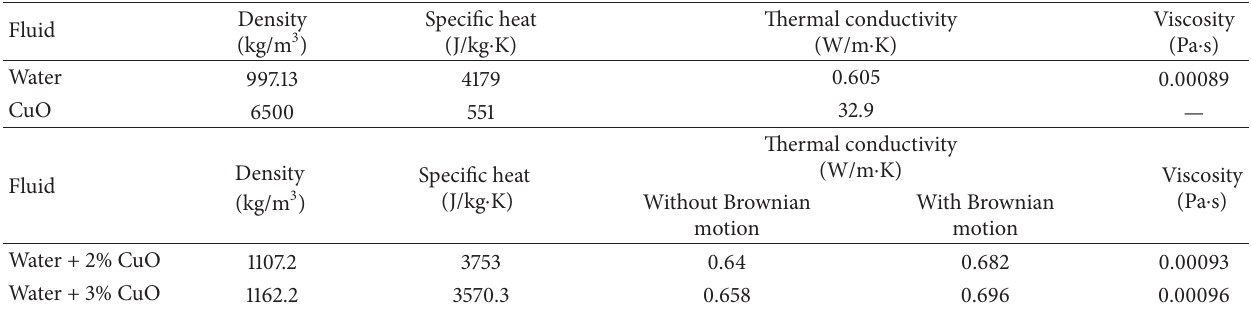
Table 4: Thermophysical properties of CuO nanofluids of different